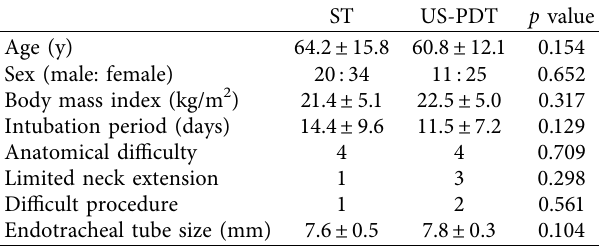
Table 1: Demographics of the patients undergoing surgical tra- cheostomy (ST; n � 54) and ultrasound-guided percutaneous di- latational tracheostomy (US-PDT; n � 36).